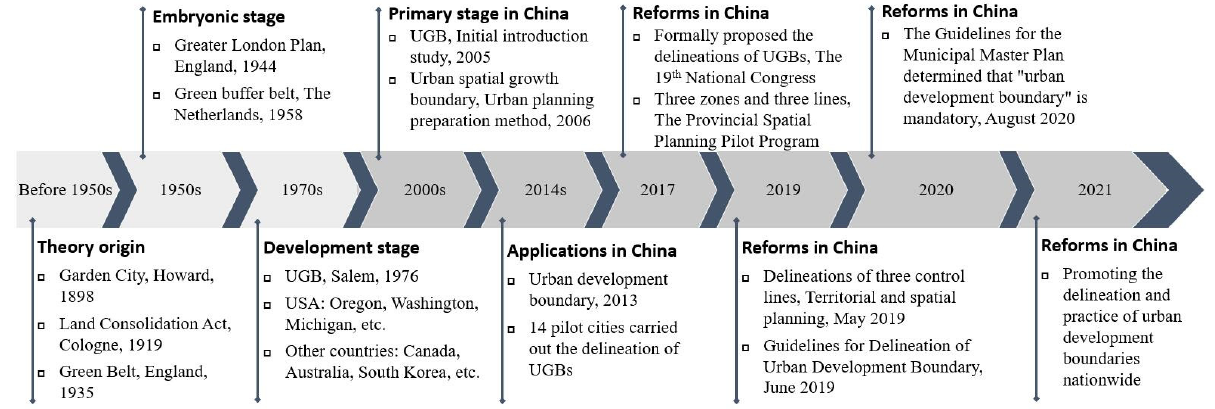
Figure 5. Development of theories and applications of urban growth